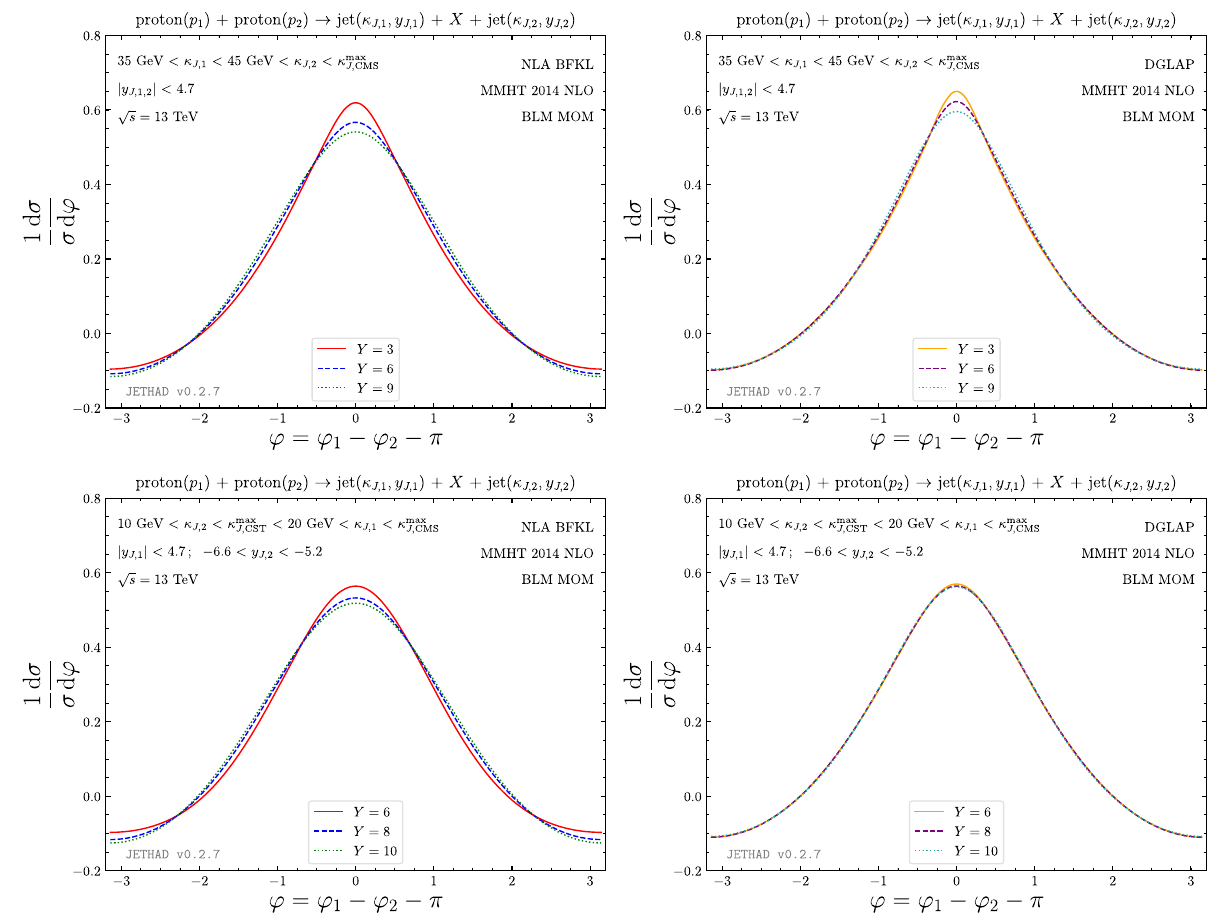
√ s = 13TeV.Resultsinthe asymmetricCMS ( CASTOR-jet ) val, Y ,and configuration are given in upper (lower)